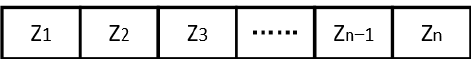
Figure 12. Brake chromosome diagram.